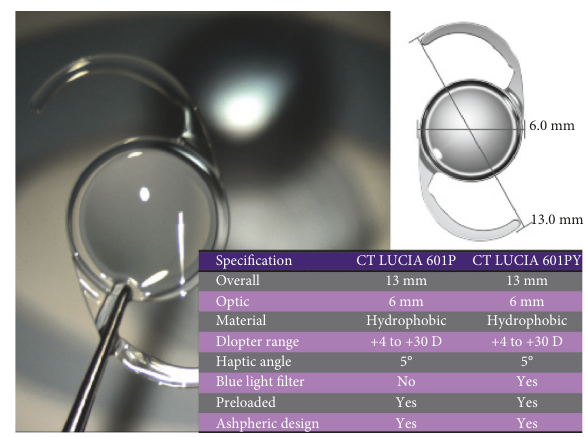
Figure 3: Specificationsof theacrylic, hydrophobicCT LUCIA601(P) (Zeiss, Germany).